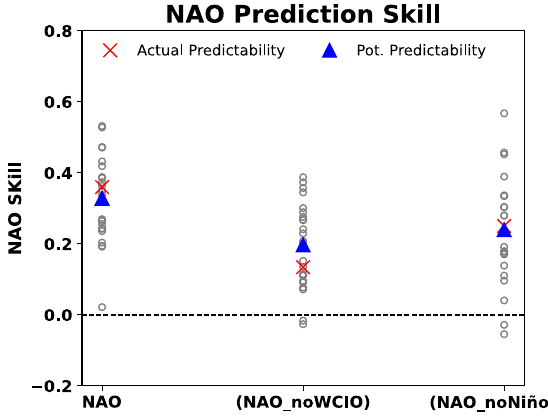
Fig. 7 NAO prediction skill. Prediction skill of the North Atlantic Oscillation (NAO) index [26:40 °N; 310:360 °E - 50:80 °N; 310:350 °E] estimated based on the 200-hPa geopotential height anomalies during early winter (November – December; ND). The grey open circle is the potential predictability for each member and the average of the 25 correlations is the potential predictability (blue triangle) of the model compared with actual prediction skill (red cross). NAO means total Skill, while NAO_noWCIO means ENSO residual signal after removing WCIO anomalies and vice-versa for the NAO_noNiño34.